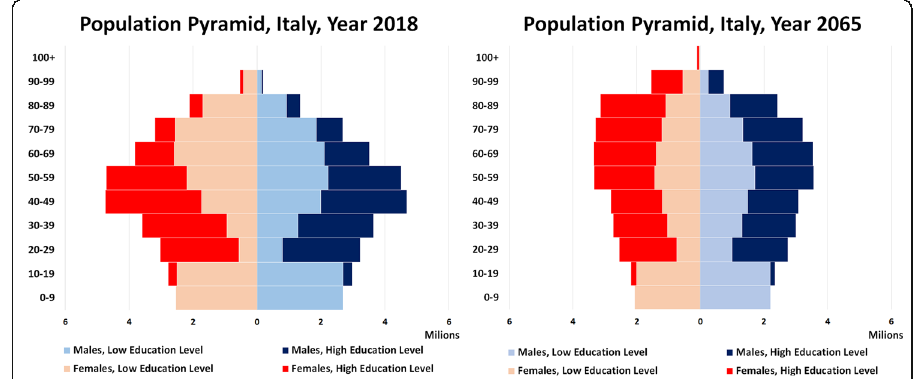
Fig. 2 Population pyramids in 2018 and 2065. ISTAT Median Scenario, Brass Constant scenario. Source: ISTA T estimate and our own